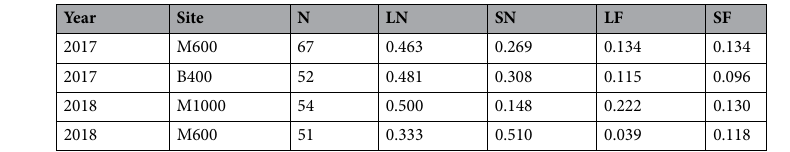
Table 1. Observed transition probabilities for each site each year. Transition probabilities from the center patch to peripheral patches of two sizes, located at two distances from the center patch with LN large near, SN small near, LF large far and SF small far. N is the total number of observed transitions for the site and year.